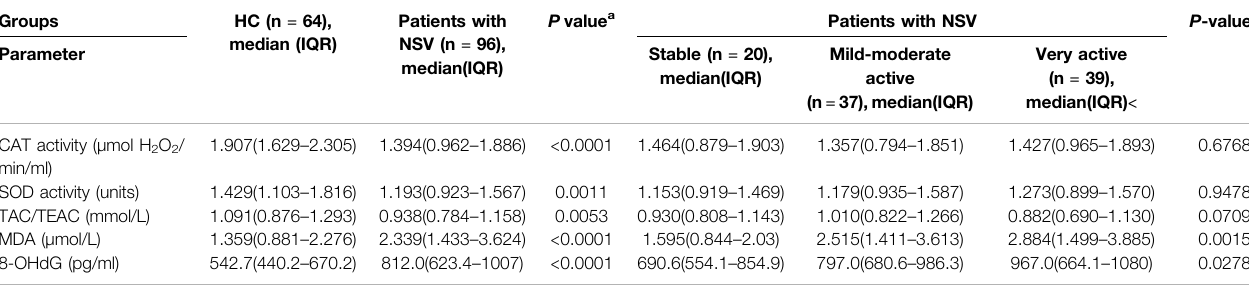
TABLE 2 | Serum levels of OS markers in HC and patients with